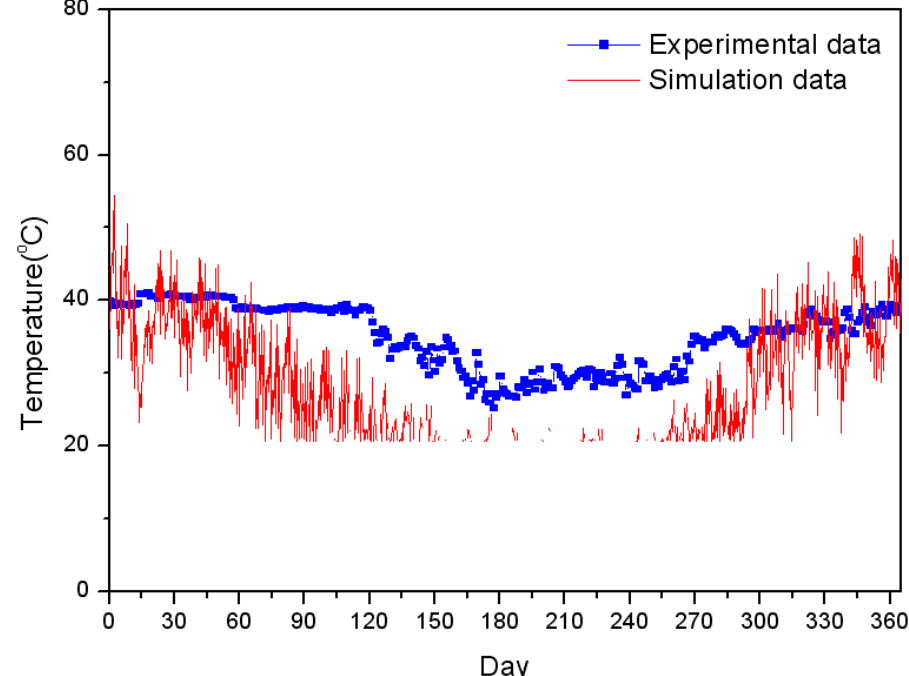
Figure 16. Comparison of experimental and optimized simulation data of temperatures of heat exchanger of group energy apartment building during a day for a year.